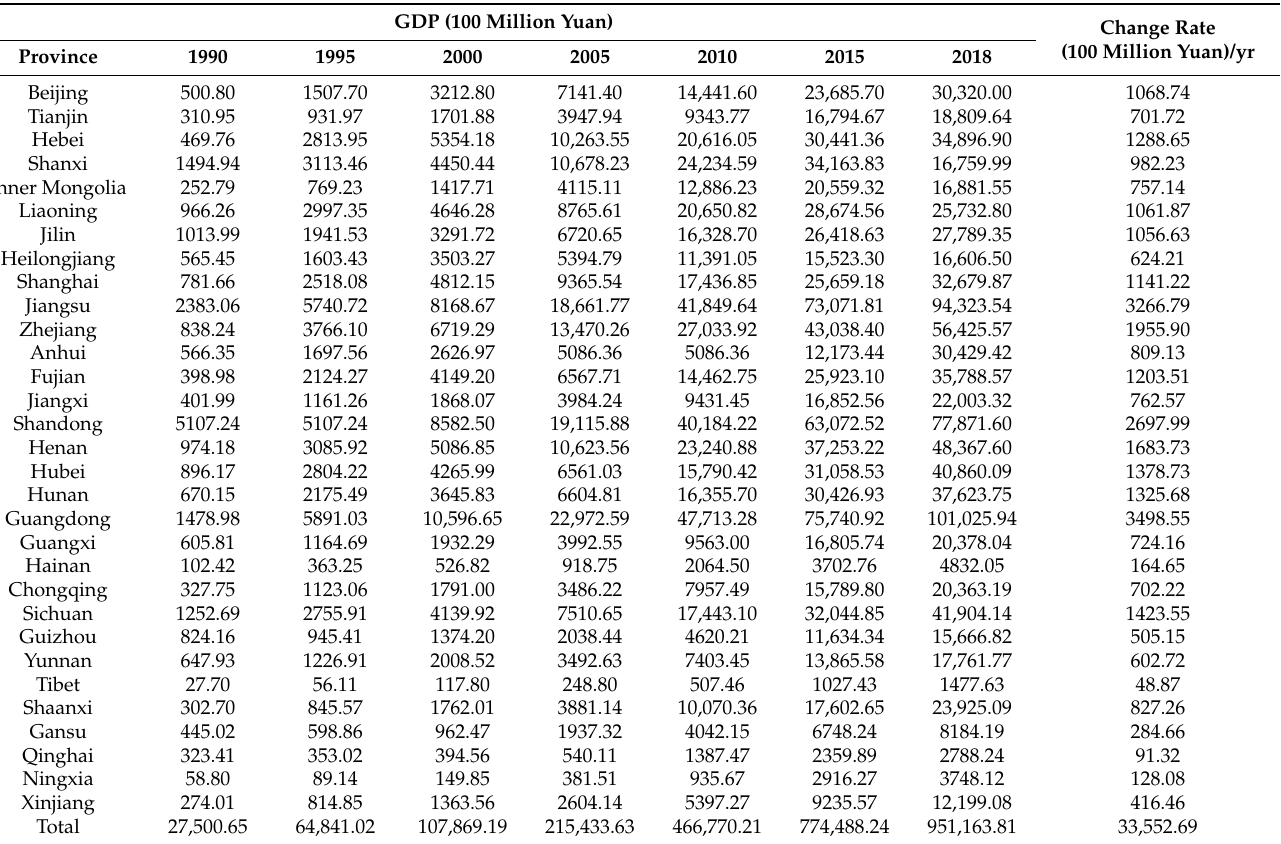
Table 3. The temporal dynamics of GDP in